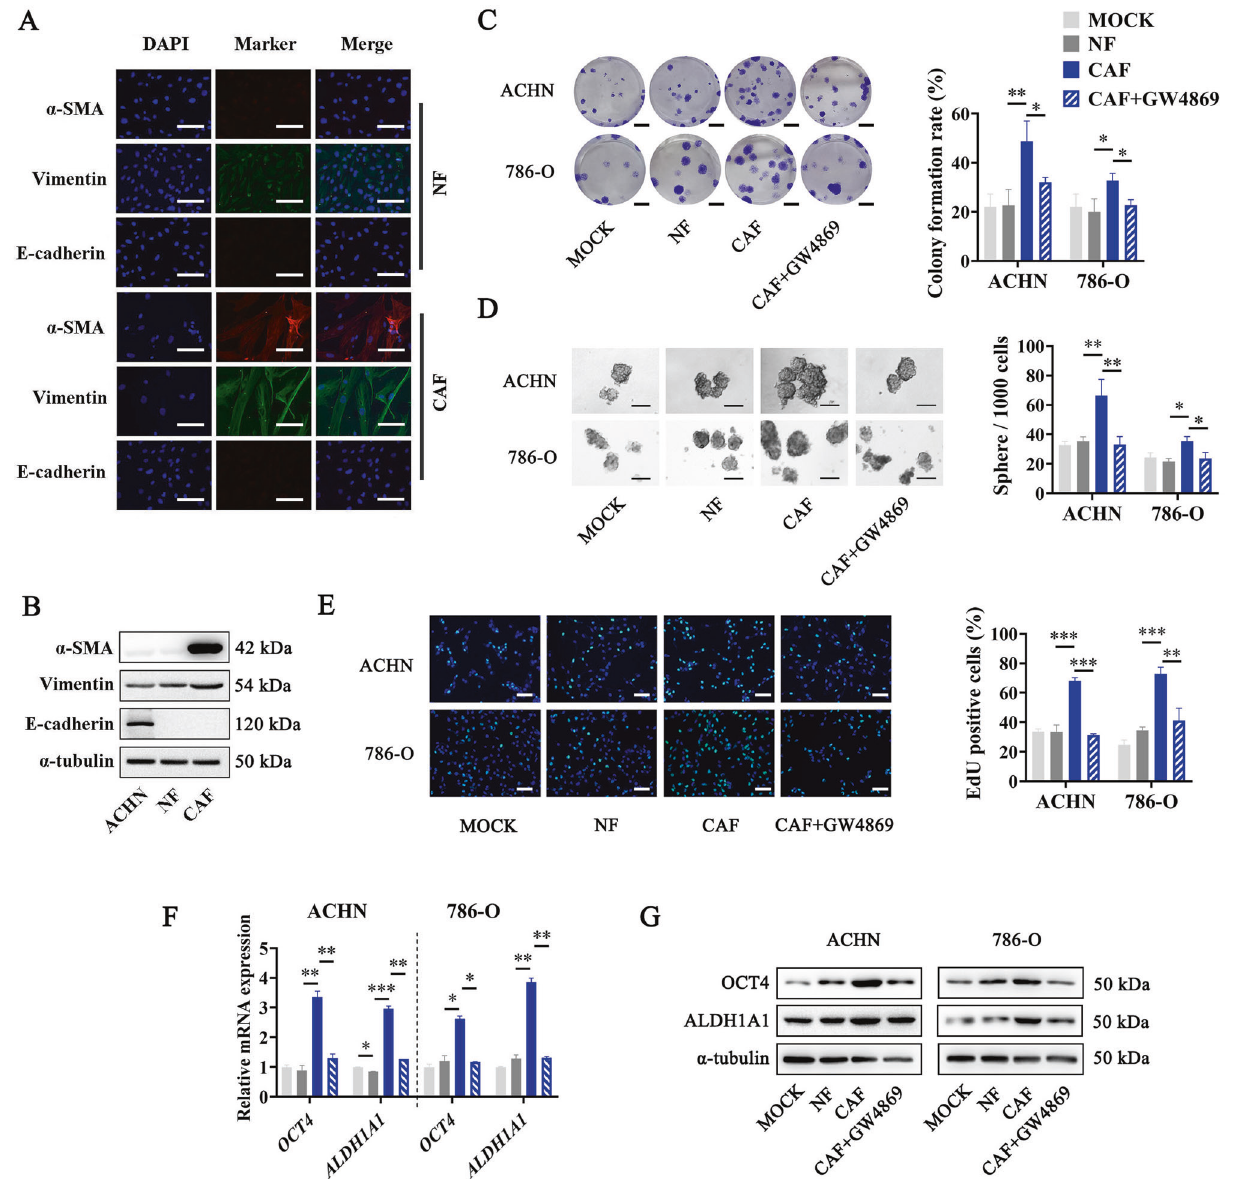
Fig. 2 CAFs promote the cancer stemness of RCC cells through secreting exosomes. A Immuno fl uorescence staining of α -SMA, Vimentin, and E-cadherin in CAFs and NFs, scale bar = 50 µm. B Western Blot analysis of α -SMA, Vimentin, and E-cadherin protein levels in CAFs, NFs, and ACHN cell line. C Representative images (Left) and histogram statistics (Right) from colony formation assay of RCC cells co-cultured with NFs, CAFs, or GW4968 pre-treated CAFs, scale bar = 0.5 cm. D Representative images (Left) and histogram statistics (Right) from sphere formation assay of RCC cells co-cultured with NFs, CAFs, or GW4968 pre-treated CAFs. E Representative images (Left) and histogram statistics (Right) from EdU assay of RCC cells co-cultured with NFs, CAFs, or GW4968 pre-treated CAFs, scale bar = 50 µm. F RT-qPCR analysis of cancer stemness relative genes OCT4 and ALDH1A1 expression in RCC cells co-cultured with NFs, CAFs, or GW4968 pre-treated CAFs, normalized to β -actin . G Western blot of OCT4 and ALDH1A1 expression in RCC cells co-cultured with NFs, CAFs, or GW4968 pre-treated CAFs, normalized to α -Tubulin. Cell experiment was repeated three times independently, P value between the two groups was obtained by Unpaired t test. * P < 0.05; ** P < 0.01; *** P <